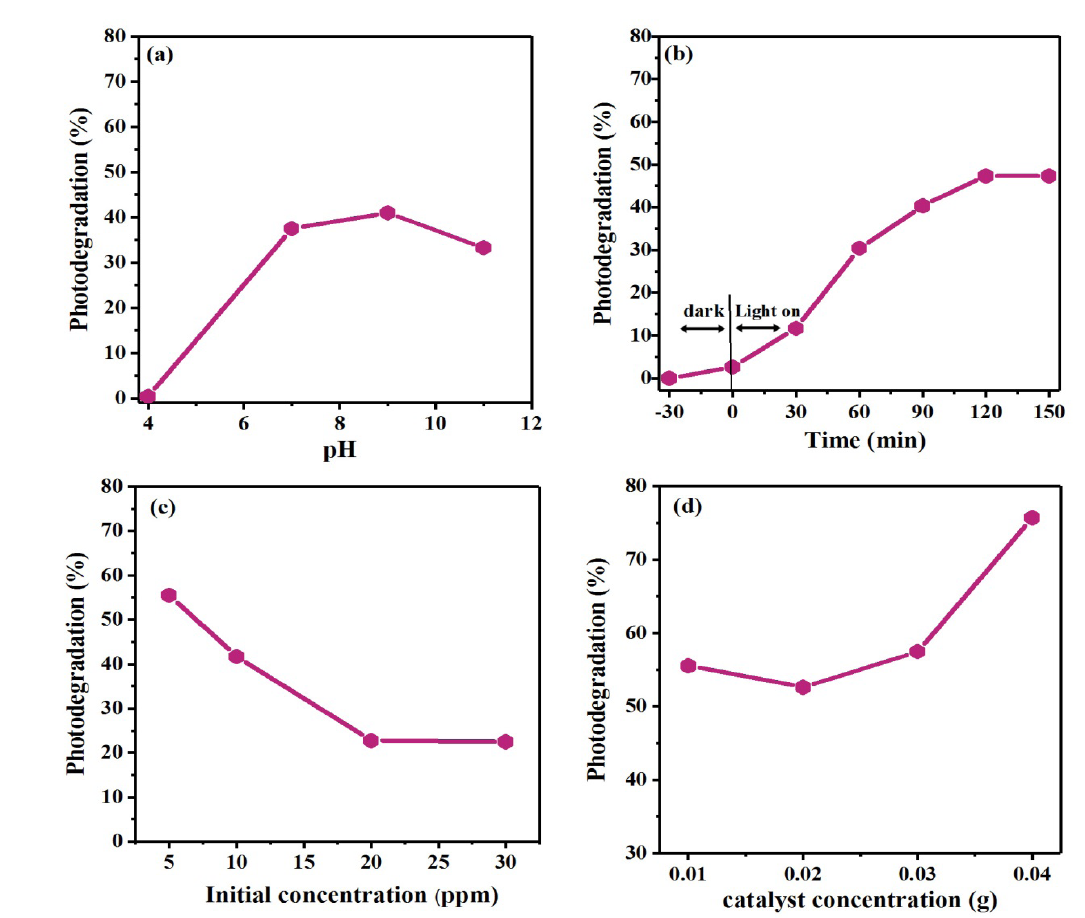
Figure 5. The experiments of performed to investigate the effects of pH, irradiation time, 2,4-D concentration, and catalyst dose on the 2,4-D photodegradation The effect of A: pH; B: Irradiation time; C: Initial 2,4-D concentration; and D: Catalyst dose on the 2,4-D photodegradation.